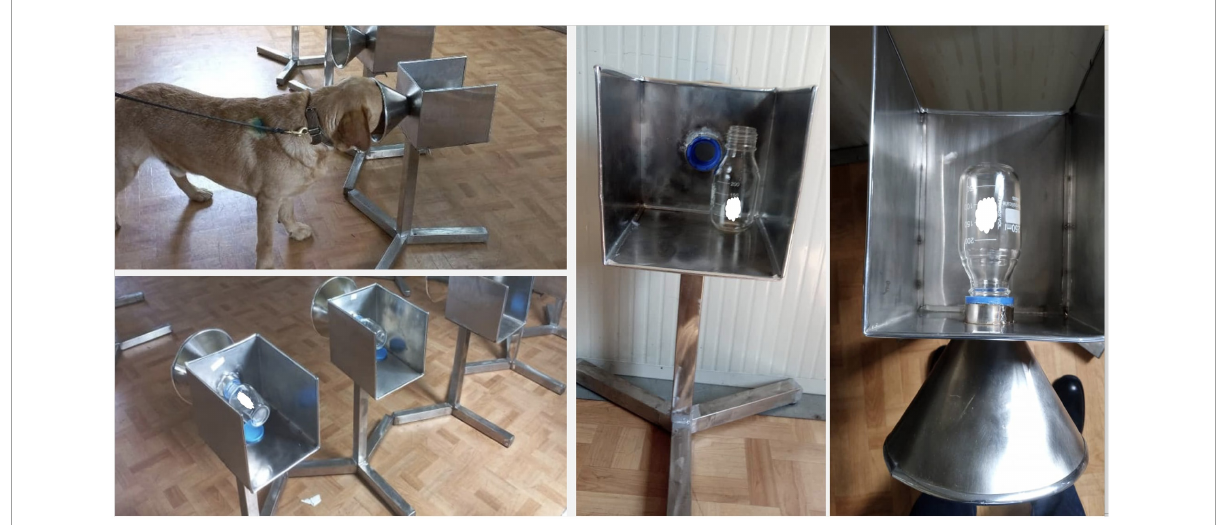
FIGURE3 Locally manufactured olfaction cones used by dogs for detection of COVID-19 in sweat samples collected from individuals on a cotton pad carried in a glass container. The containers are covered with grids, which allowed the odor to escape and reach the sniffing hole. Each tube extension is identical and shaped in a way that it prevents dogs from physical contact with the samples.